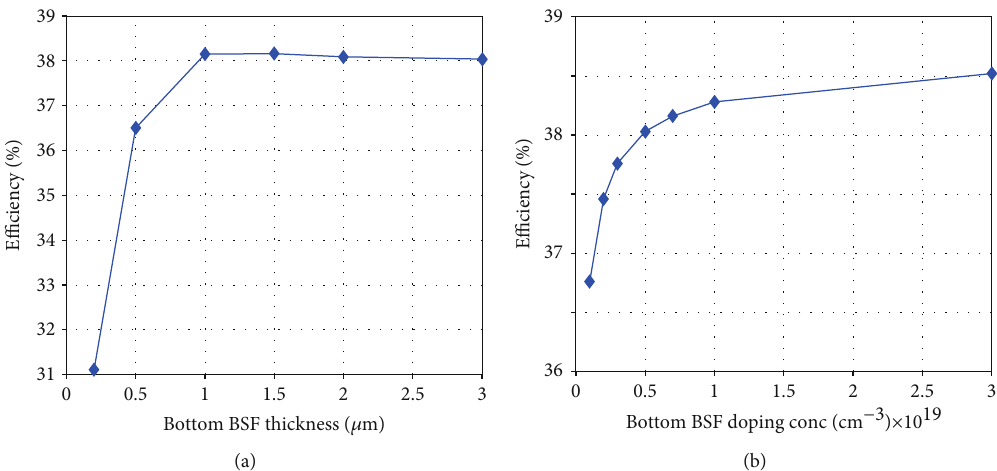
Figure 10: Optimization of the bottom BSF parameters. (a) Cell e ffi ciency vs. thickness. (b) Cell e ffi ciency vs. doping concentration.